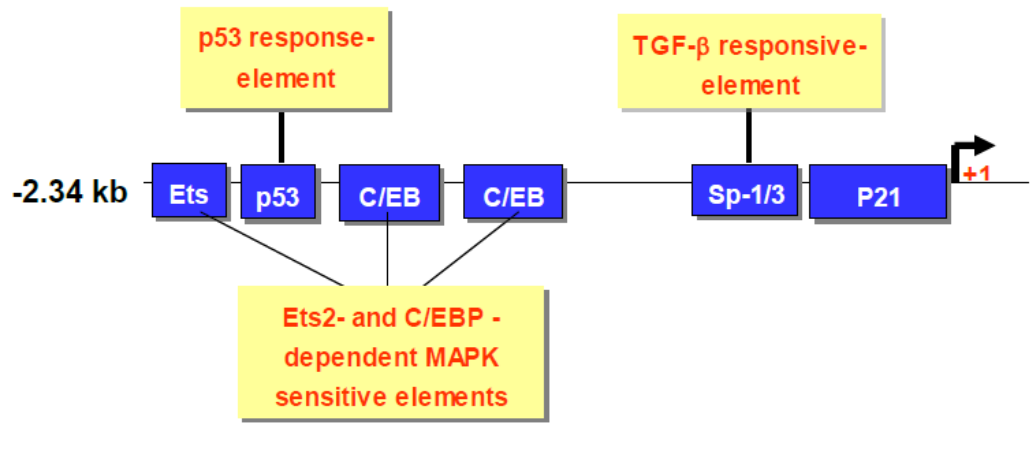
Figure 3. Schematic representation of p21 binding sites for p53, pERK1/2 and TGF